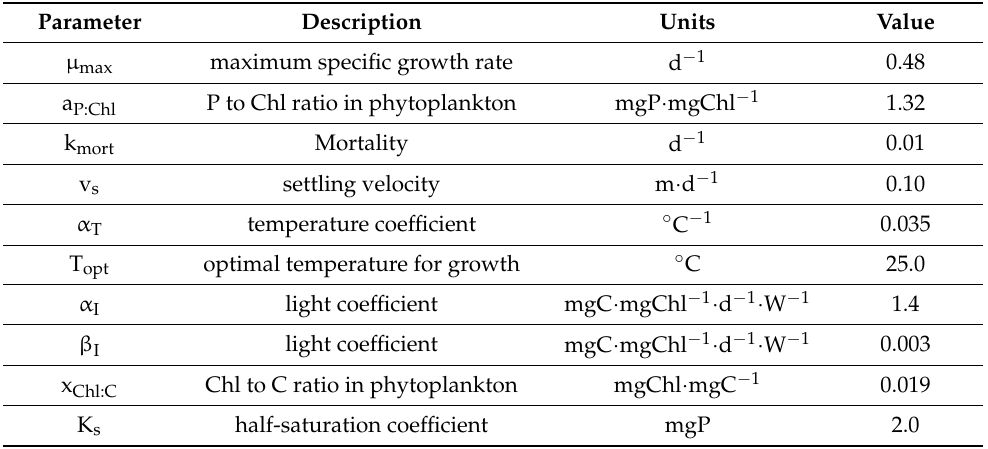
Table 1. GEM module biolinetic